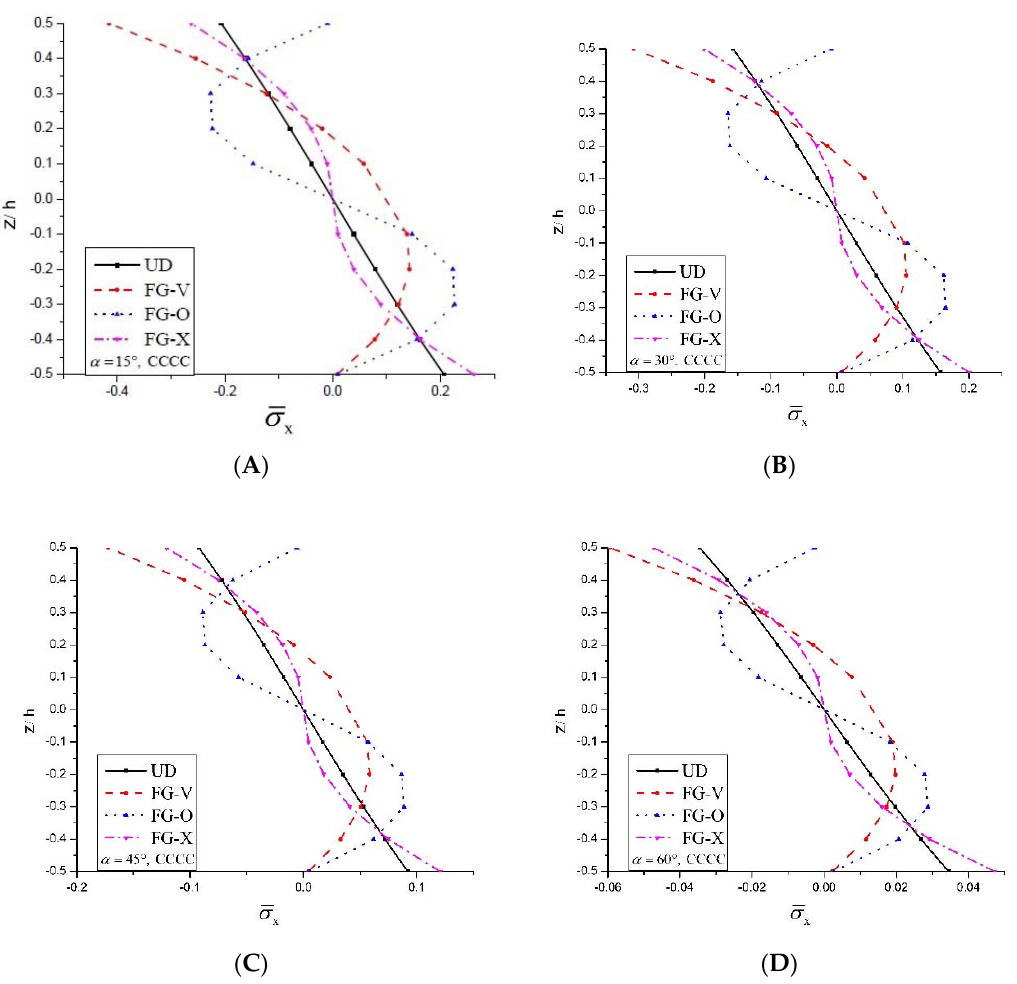
Figure 10. Variation of non-dimensional axial stress for FG-CNT-reinforced rhombic plate subjected to sin ‐ sin loading ( A ) α = 15°, ( B ) α = 30°, ( C ) α = 45° and ( D ) α = 60°.